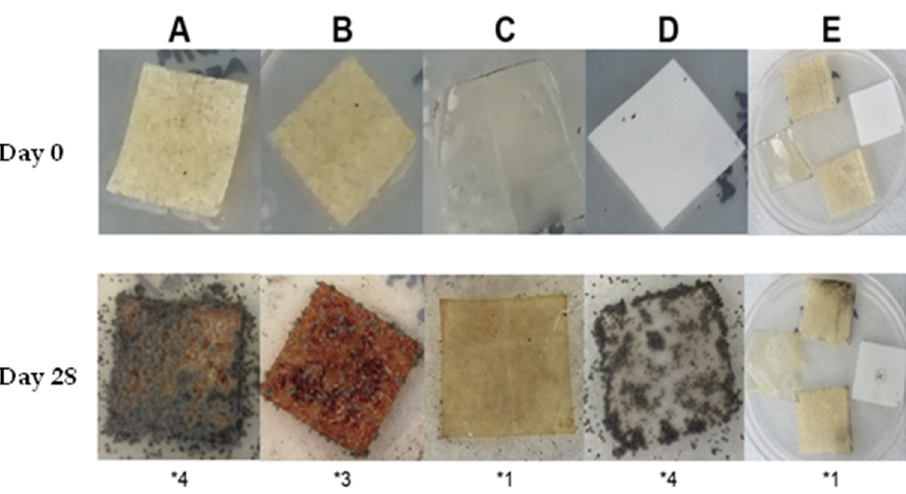
8 of 17 Figure 4. Films’ spectrogram. ( A ) Corn cob cellulose (C), ( B ) Cellulose–Chitosan (C-CH), ( C ) Cellulose–Cellulose nanocrystals–Chitosan (C-NC-CH) and ( D ) Chitosan (CH).